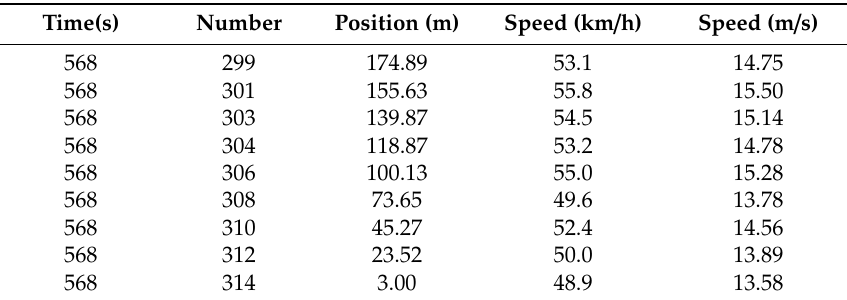
Table 2. Initial speed information on lane 2.